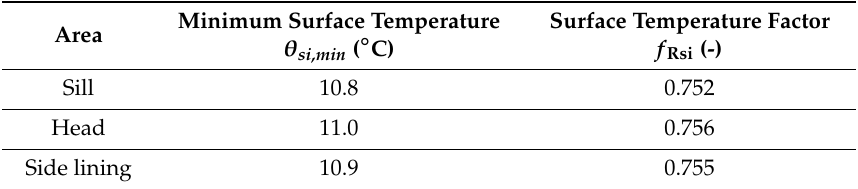
Table 7. Minimum surface temperature and surface temperature factor for variant II, coupled to the